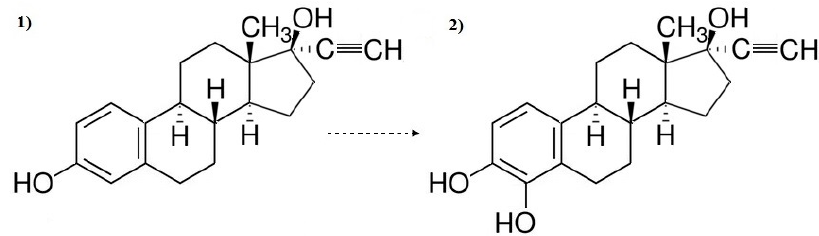
Figure 14. Identified 1 17 α -ethinylestradiol by-product, where 2 is 2-hydroxy-17 α -ethinylestradiol.